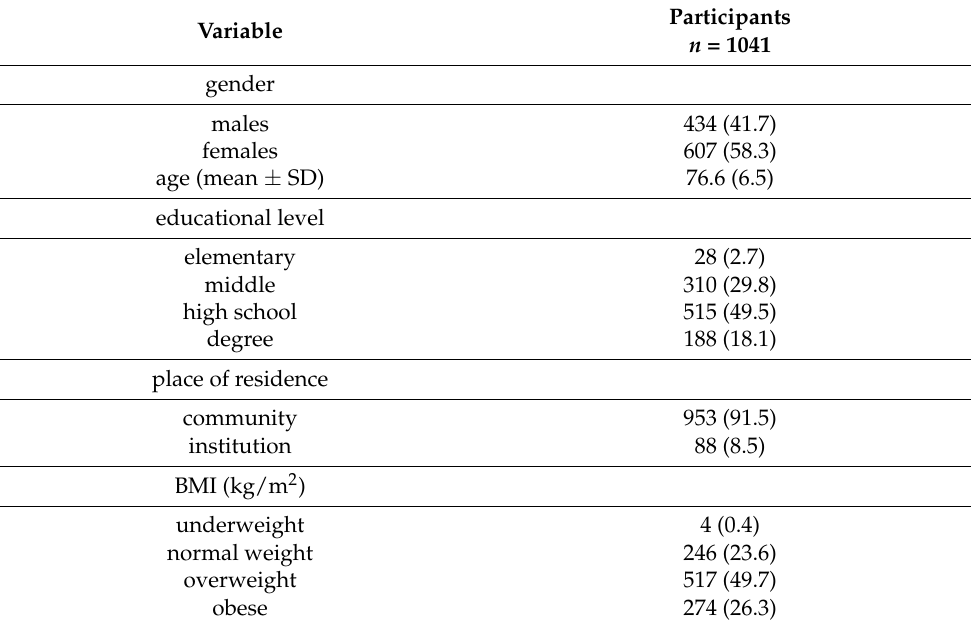
Table 1. Socio-demographic, anthropometric and behavioral characteristics of